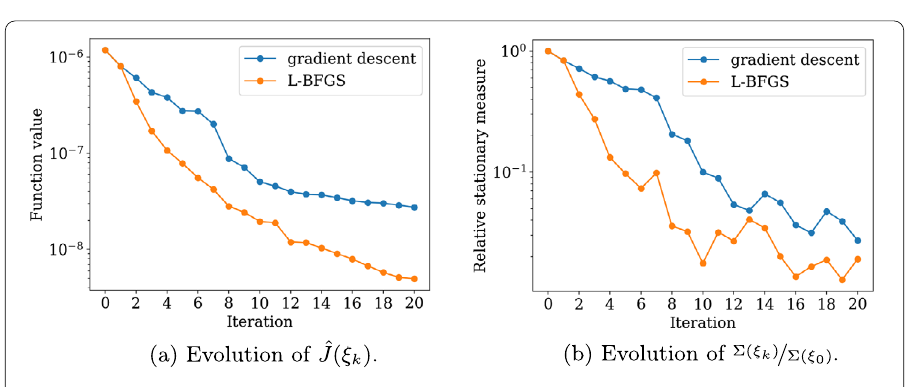
Figure 4 Convergence history of the optimization